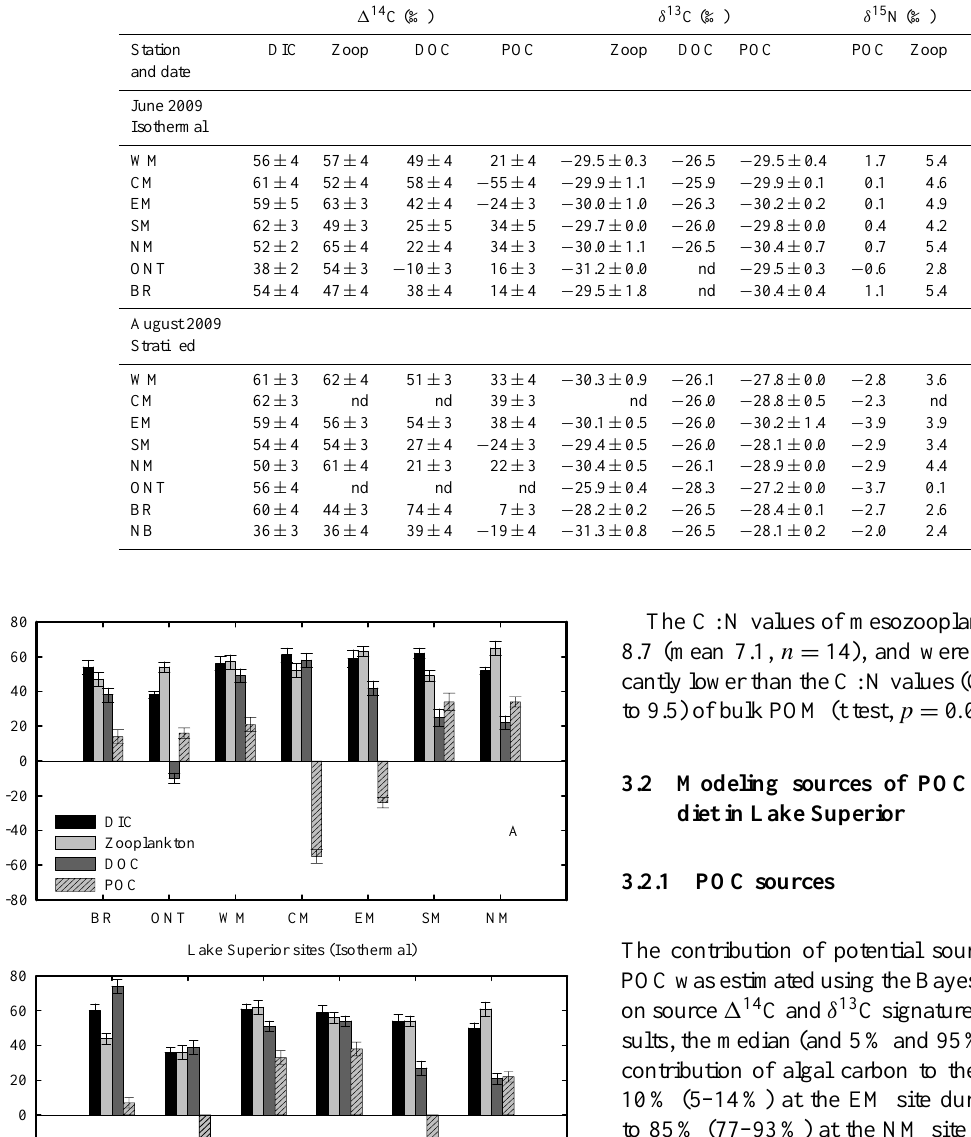
Table 2. Radiocarbon, stable isotope and atomic C:N ratio of zooplankton (Zoop) and organic and inorganic carbon pools in the surface waters of Lake Superior. Precision of radiocarbon values is based on analyses of multiple external standards, and those of stable isotopes are based on replicate sample analyses.